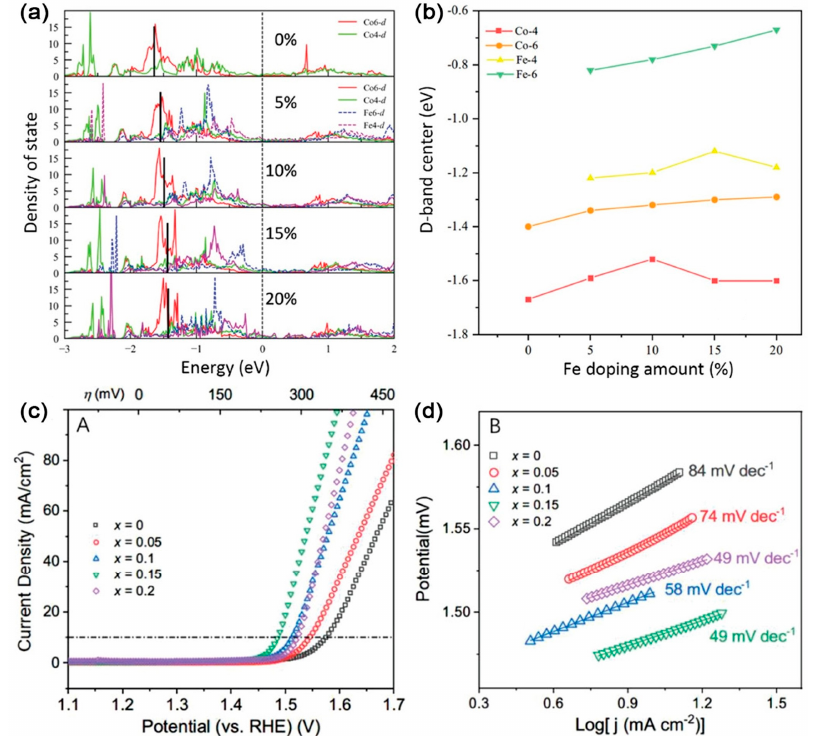
Figure 7. ( a ) Density of states of (Co 1 − x Fe x ) 9 S 8 for x = 0, 0.05, 0.1, 0.15, 0.2, respectively. The black solid line shows the d-band center of the bulk phase. ( b ) The d-band center of Fe and Co in various polyhedrons coordinated with 4 or 6 S atoms. ( c ) i R − corrected linear sweep voltammetry curves. ( d ) Tafel plots of the prepared samples. Reproduced with permission from ref. [107]. Copyright 2020,